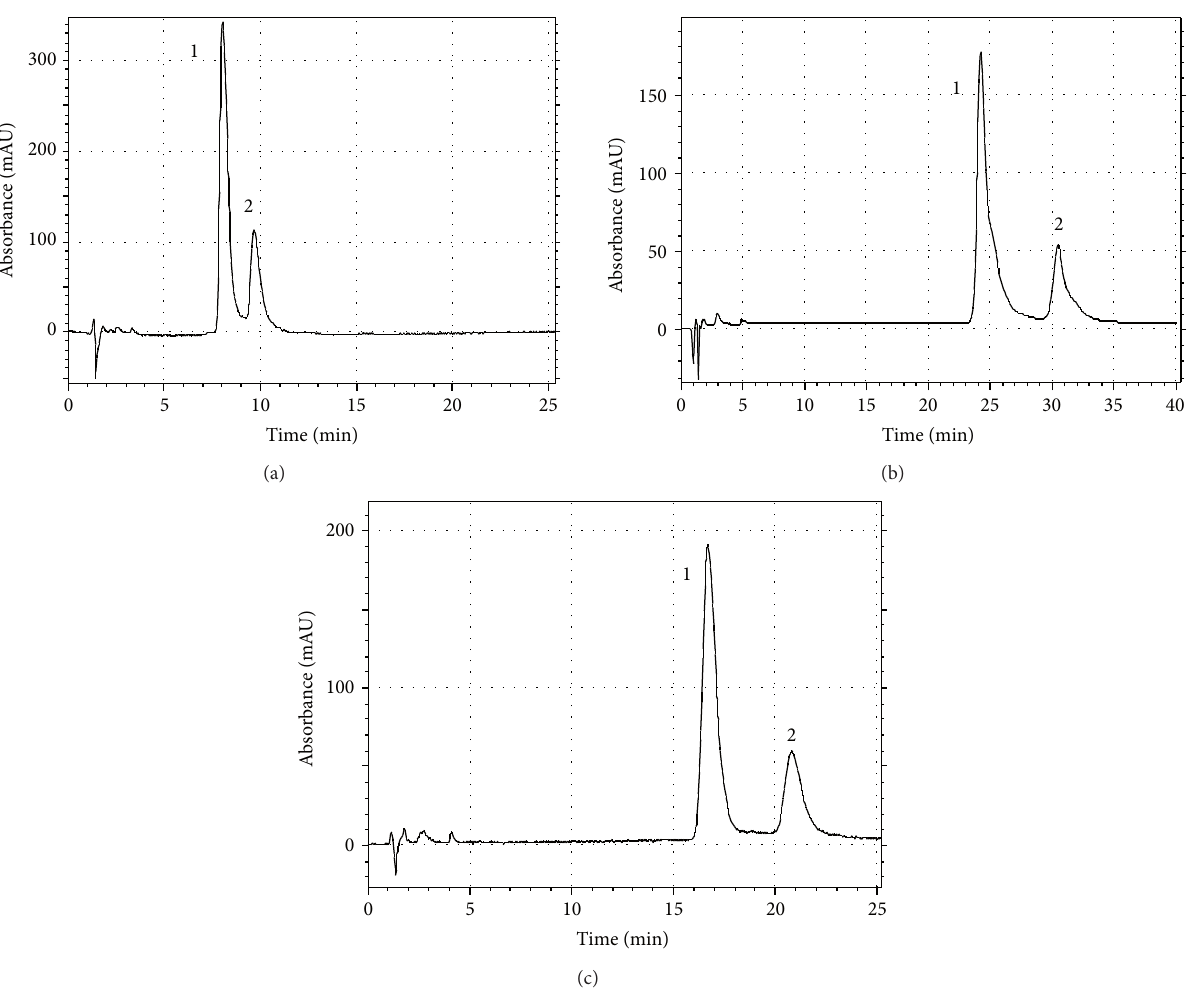
F 2: Chromatograms of permethrin obtained using the mobile phase, consisting of: (a) ethanol:water (70:30, v/v); (b) ethanol:water (65:35, v/v) and (c) ethanol:phosphoric acid solution (pH = 3) (67:33, v/v). Peak 1 = trans -, peak 2 = cis -isomers.